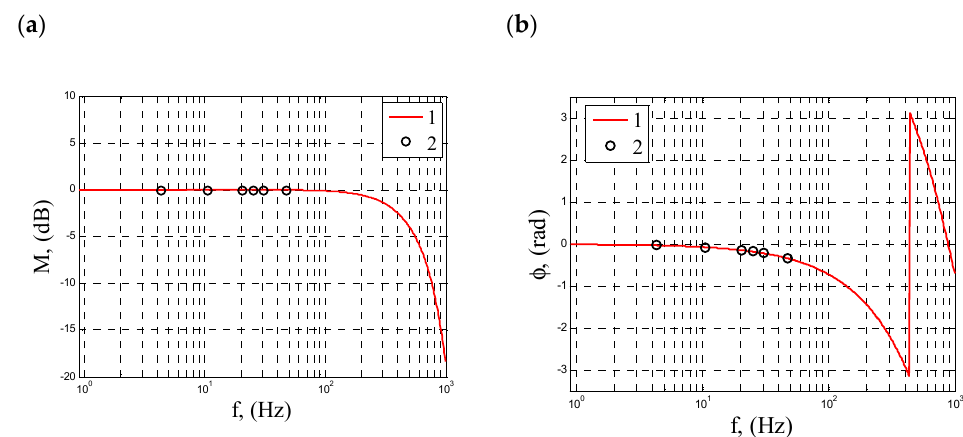
Figure 10. Points of the frequency characteristics of the ( a ) amplitude and ( b ) phase of the tested analog filter used in the measuring line of the current supplying the stator, determined by the suggested method, against the theoretical Bodé characteristics of this filter; 1—theoretical frequency characteristics of the filter, 2—results of the suggested method. Table 3. Deviation in phase shift angle ϕ u( i ) between the input and output signals of the tested analog filter, determined by the suggested method, and the theoretical values ϕ